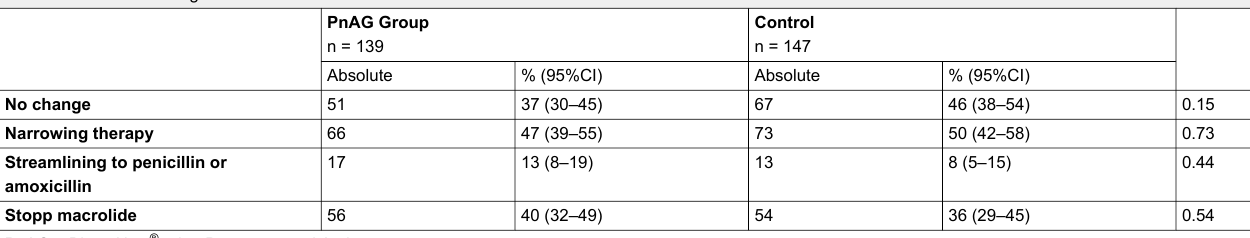
Table 4: Treatment